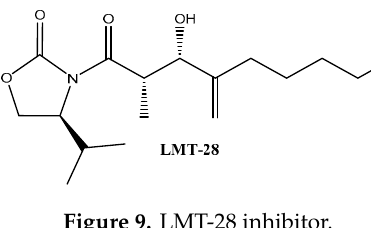
Figure 9. LMT-28 inhibitor.